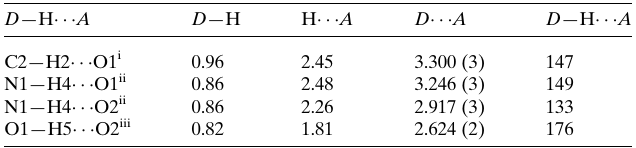
Table 2 Experimental details.